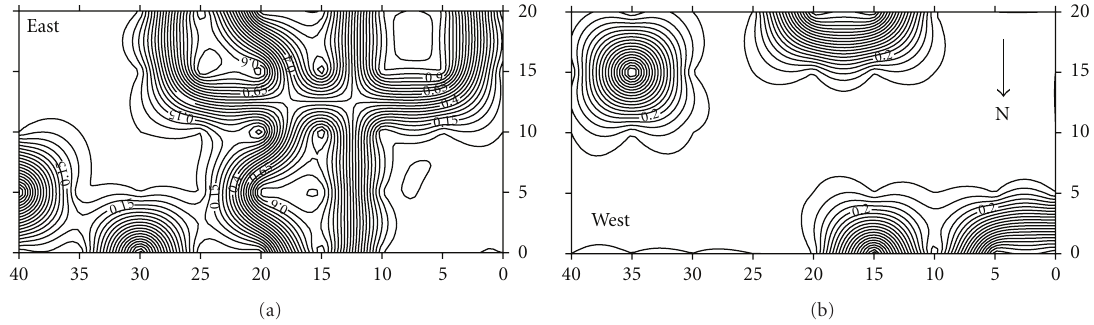
Figure 3: Distribution of termite activity as measured by attacked stakes. (a) The eastern grove, (b) western grove. Increasing contour values indicate increasing probability of termite activity.